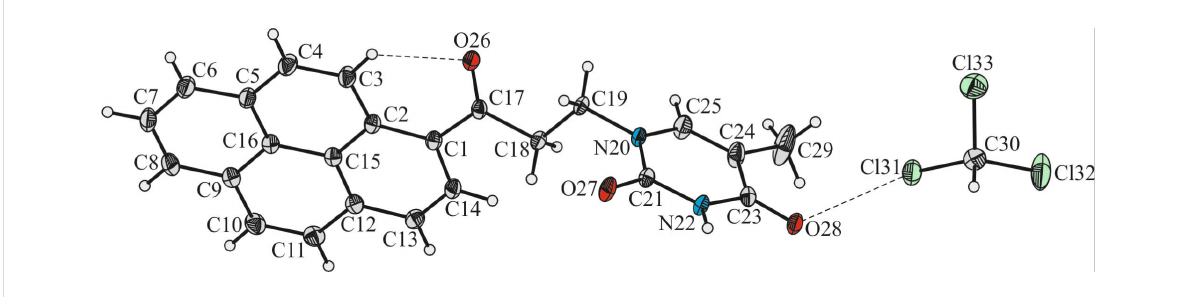
Figure 2: ORTEP diagram of 2 at 50% probability level. The hydrogen and halogen bonds are represented by dashed lines. Selected bond lengths (Å) and angles (°): O26–C17, 1.223(2); O27–C21, 1.233(2); O28–C23, 1.225(2); N20–C25, 1.380(2); N22–C21, 1.372(2); N22–C23, 1.389(2); C1–C17, 1.501(2); C1–C2, 1.428(2); C15–C16, 1.433(2); C12–C13, 1.399(2); C30–Cl31···O28, 2.972(2); C3–H3···O26, 2.879(2); C1–C17–O16, 123.78(15); N22–C23–C24, 114.79(15); O27–C21–N22, 121.79(15); O27–C21–N20, 122.60(15); N20–C21–N22, 115.61(14); C2–C1–C17,